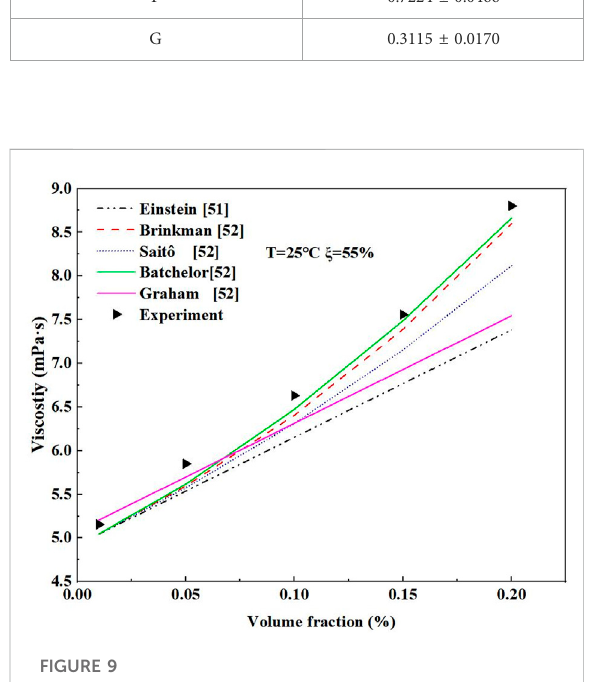
FIGURE 9 Comparison of experimental value and classical model calculated values of nano-LiBr viscosity.